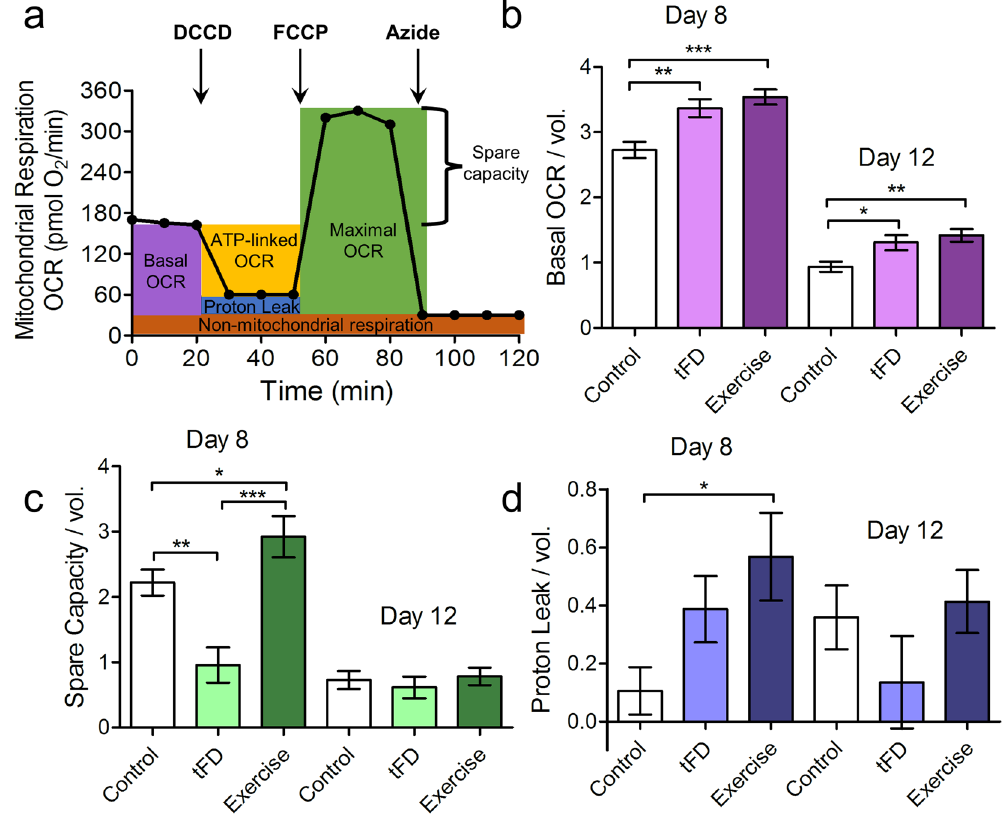
Figure 4. Exercise and transient food deprivation impact mitochondrial basal respiration, spare capacity, and proton leak. For experiments, nematodes were washed off plates, rinsed, and allowed to clear their guts for 20 minutes. The animals were rinsed once more and then loaded into 24-well Seahorse plates, 25 nematodes per well, for measurement of oxygen consumption rate (OCR). All OCR measurements are normalized per nematode and per average nematode volume due to size differences between groups (Supplemental Figure S1). Final units are pmol O 2 /min/nematode/ µ m 3 × 10 3 . Basal OCR was measured along with OCR following injection of FCCP, DCCD, or sodium azide (Panel a). These measurements were then normalized per nematode and per volume and used to calculate the following parameters: Panel b, basal respiration, Panel c, spare capacity (FCCP response – basal OCR), and Panel d, proton leak (DCCD response – sodium azide response). Statistical significance was assessed by a two-way ANOVA followed by a Bonferroni posttest comparing all groups to each other. Data represents the mean and standard error from 3 biological replicates. Asterisks represent statistical significance: * p < 0.05; ** p < 0.01; *** p <